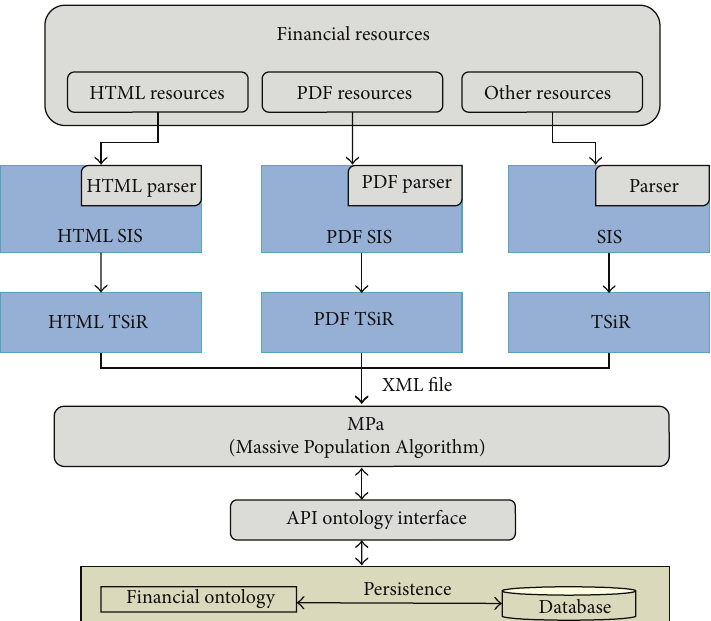
Figure 2: Architecture of the Ontology Population system.